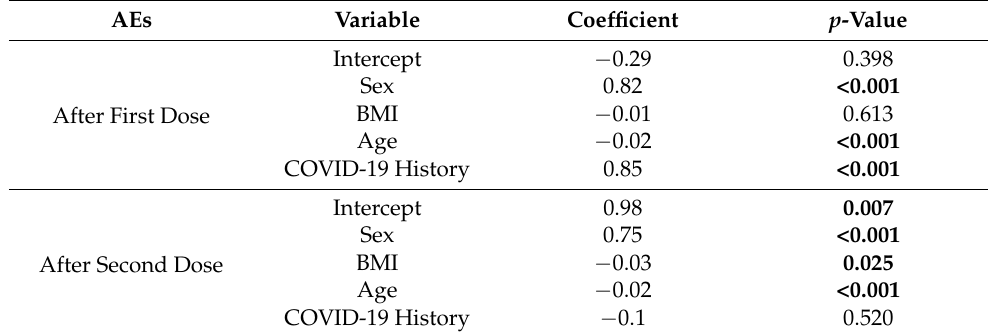
Table 2. Results of logistic regression after first and second dose. Features showing significant association with AEs after the first or second dose are highlighted in bold. AEs Variable Coefficient p -Value Intercept − 0.29 0.398 Sex 0.82 <0.001 BMI − 0.01 0.613 After First Dose Age − 0.02 <0.001 COVID-19 History 0.85 <0.001 Intercept 0.98 0.007 Sex 0.75 <0.001 BMI − 0.03 0.025 After Second Dose Age − 0.02 <0.001 COVID-19 History − 0.1